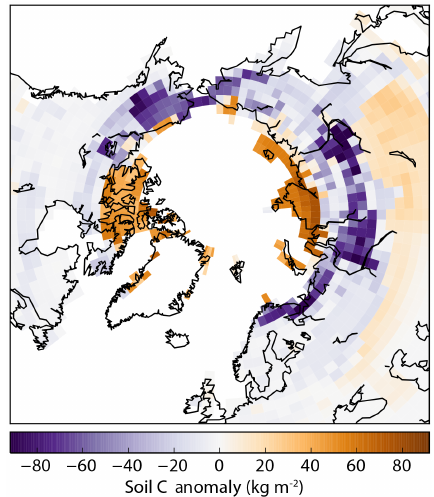
Figure 10. Difference between soil carbon density in the Northern Hemisphere between 1875 and 5250CE under continued RCP 4.5 forcing. A large permafrost carbon pool has developed in the high arctic by year